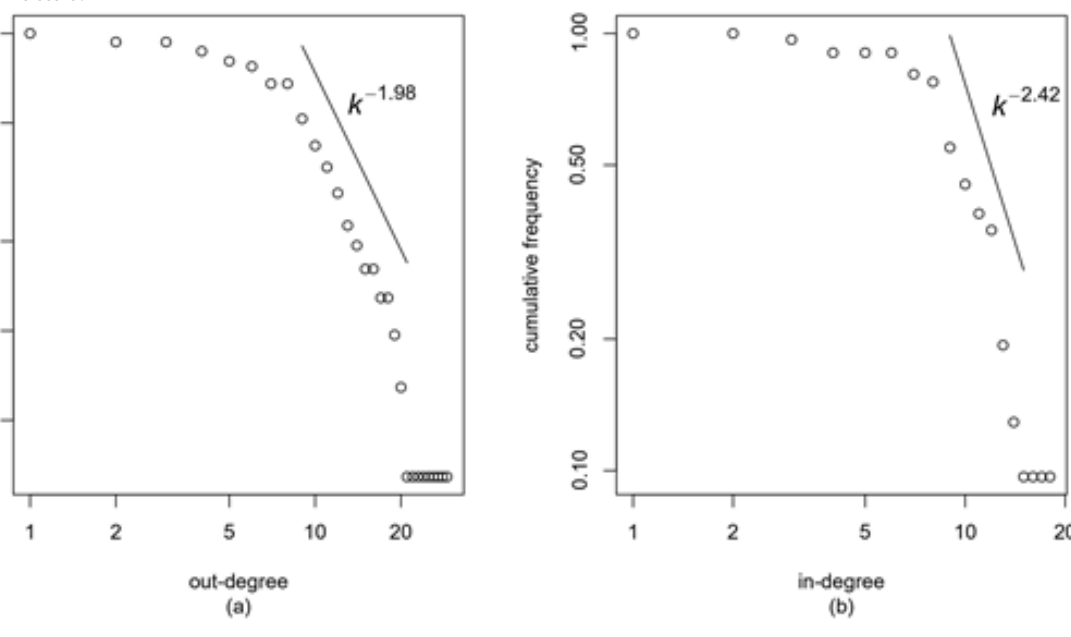
Figure 2. Cumulative frequency graphs of the out-degrees and in-degrees. (a) The cumulative distribution of the out-degrees follows an approximate power law with exponent γ =1.98. (b) The cumulative distribution of the in-degrees follows an approximate power law with exponent γ =2.42. Both axes are in logarithmic